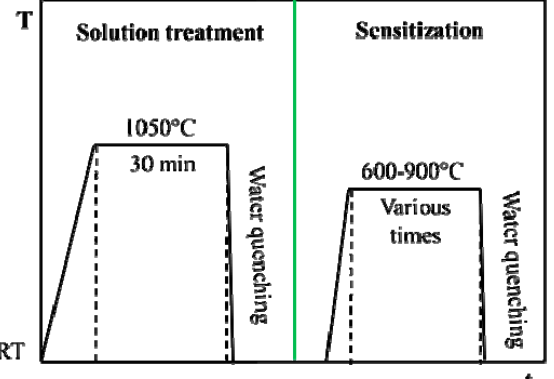
Figure 2. The heat treatment process of Cr–Mn–Ni–N–Cu austenitic stainless steel.